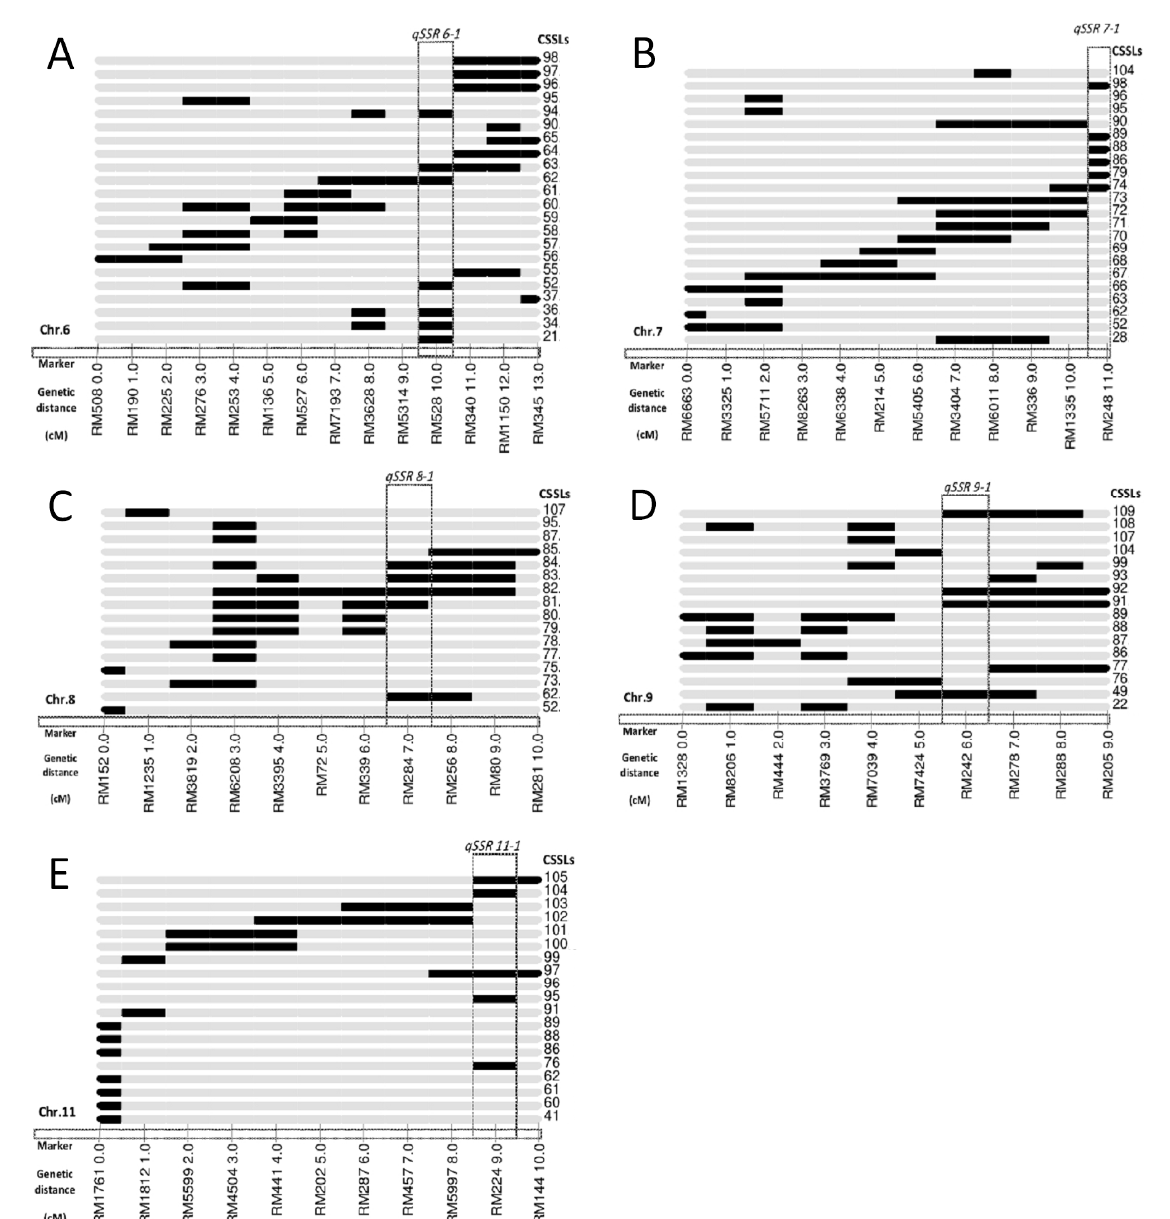
Figure 4. Substitution mapping of qSSR6-1 ( A ), qSSR7-1 ( B ), qSSR8-1 ( C ), qSSR9-1 ( D ) and qSSR11-1 ( E ) for SSR on rice chromosomes.